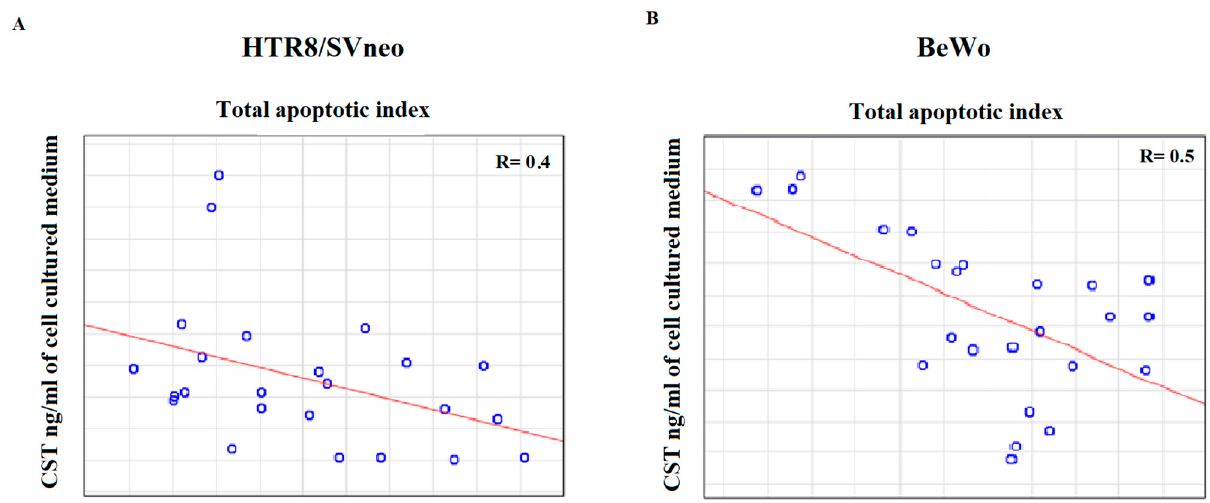
Figure 5. Spearman’s rank-order correlation between CST level and total apoptotic index (index for early and late apoptosis): ( A ) HTR-8/SVneo; ( B ) BeWo cell line.